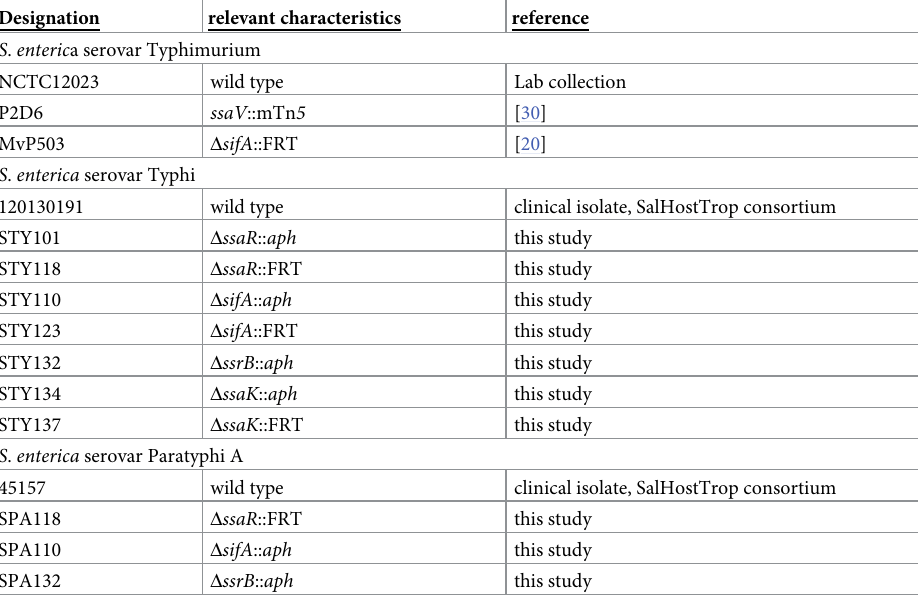
Table 1. Bacterial strains used in this